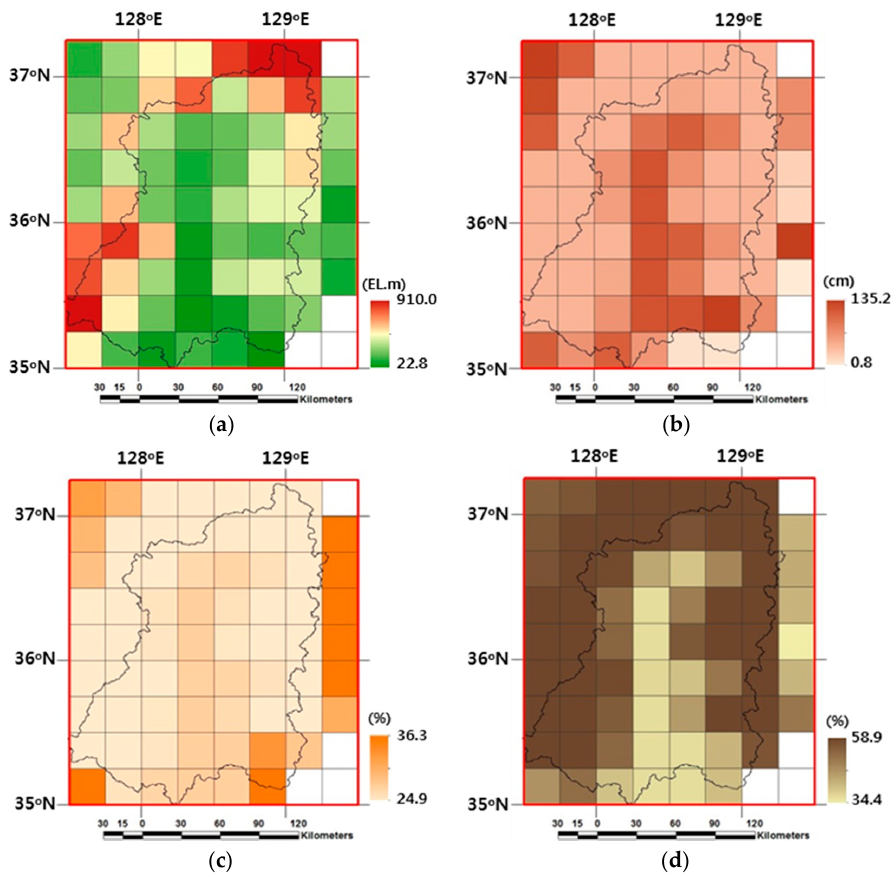
Figure 3. Spatial distributions of terrain surface boundary conditions for ( a ) surface elevation; ( b ) bedrock depth; ( c ) the first soil layer’s sand fraction; and ( d ) the first soil layer’s clay fraction on 30-km computational grids over the study domain.